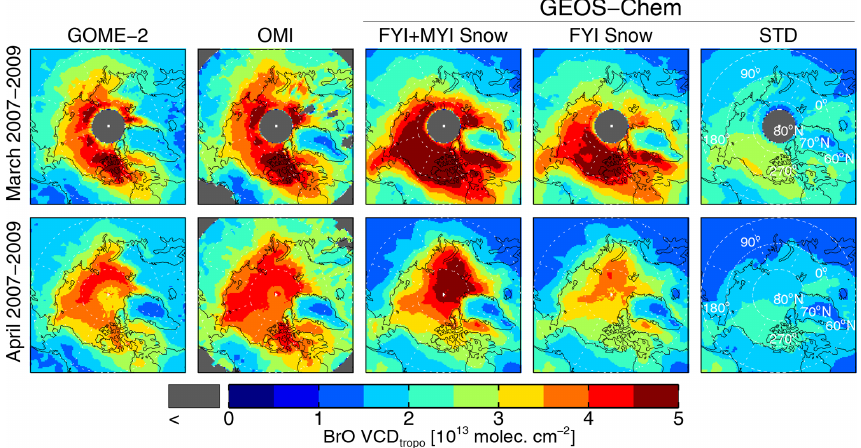
Figure 2. Spatial distribution of VCD tropo in March (top row) and April (bottom row) 2007–2009. Satellite retrievals from GOME-2 and OMI are compared to the GEOS-Chem FYI+MYI Snow, FYI Snow, and STD